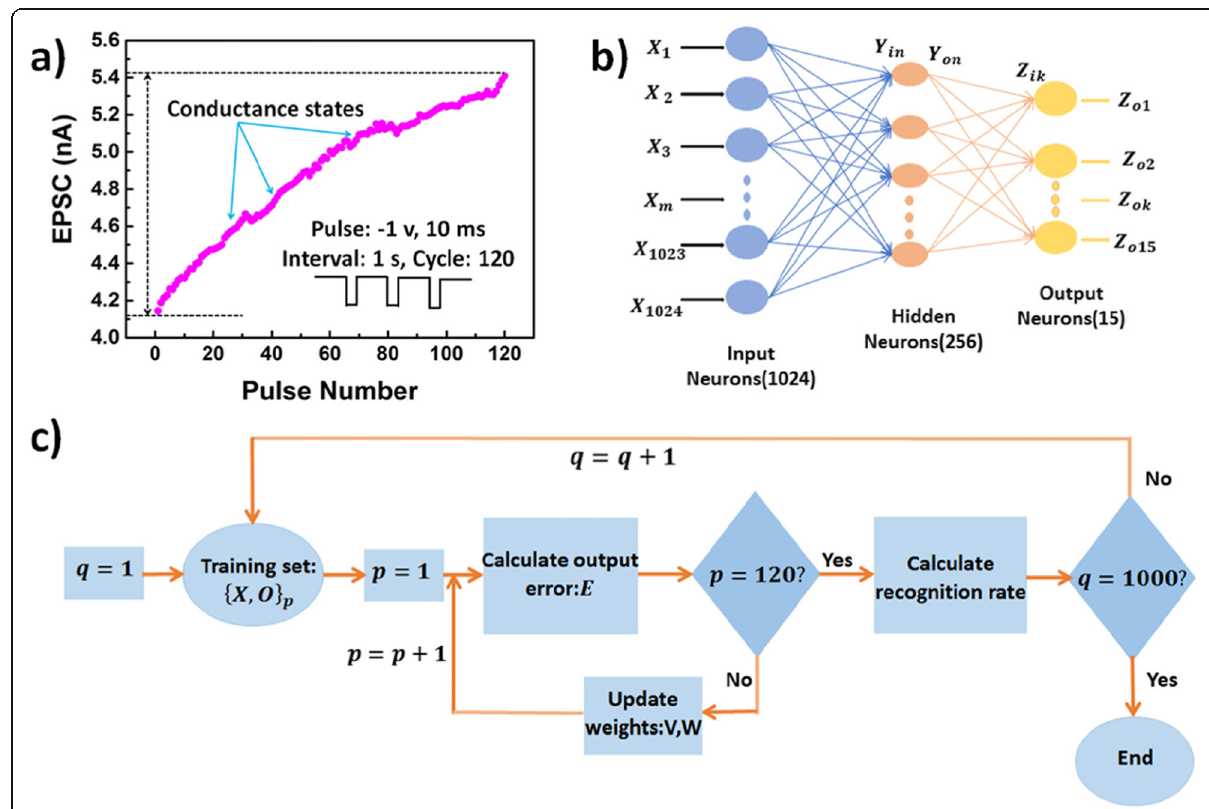
Fig. 4 Artificial neural network for face recognition. a 120 conductance states after applying 120 negative pulses ( − 2 V, 10 ms, and with a 1-s interval between pulses). b The three-layer ANN with 1024 input neurons, 256 hidden neurons, and 15 output neurons. c Flowchart of the training-recognition